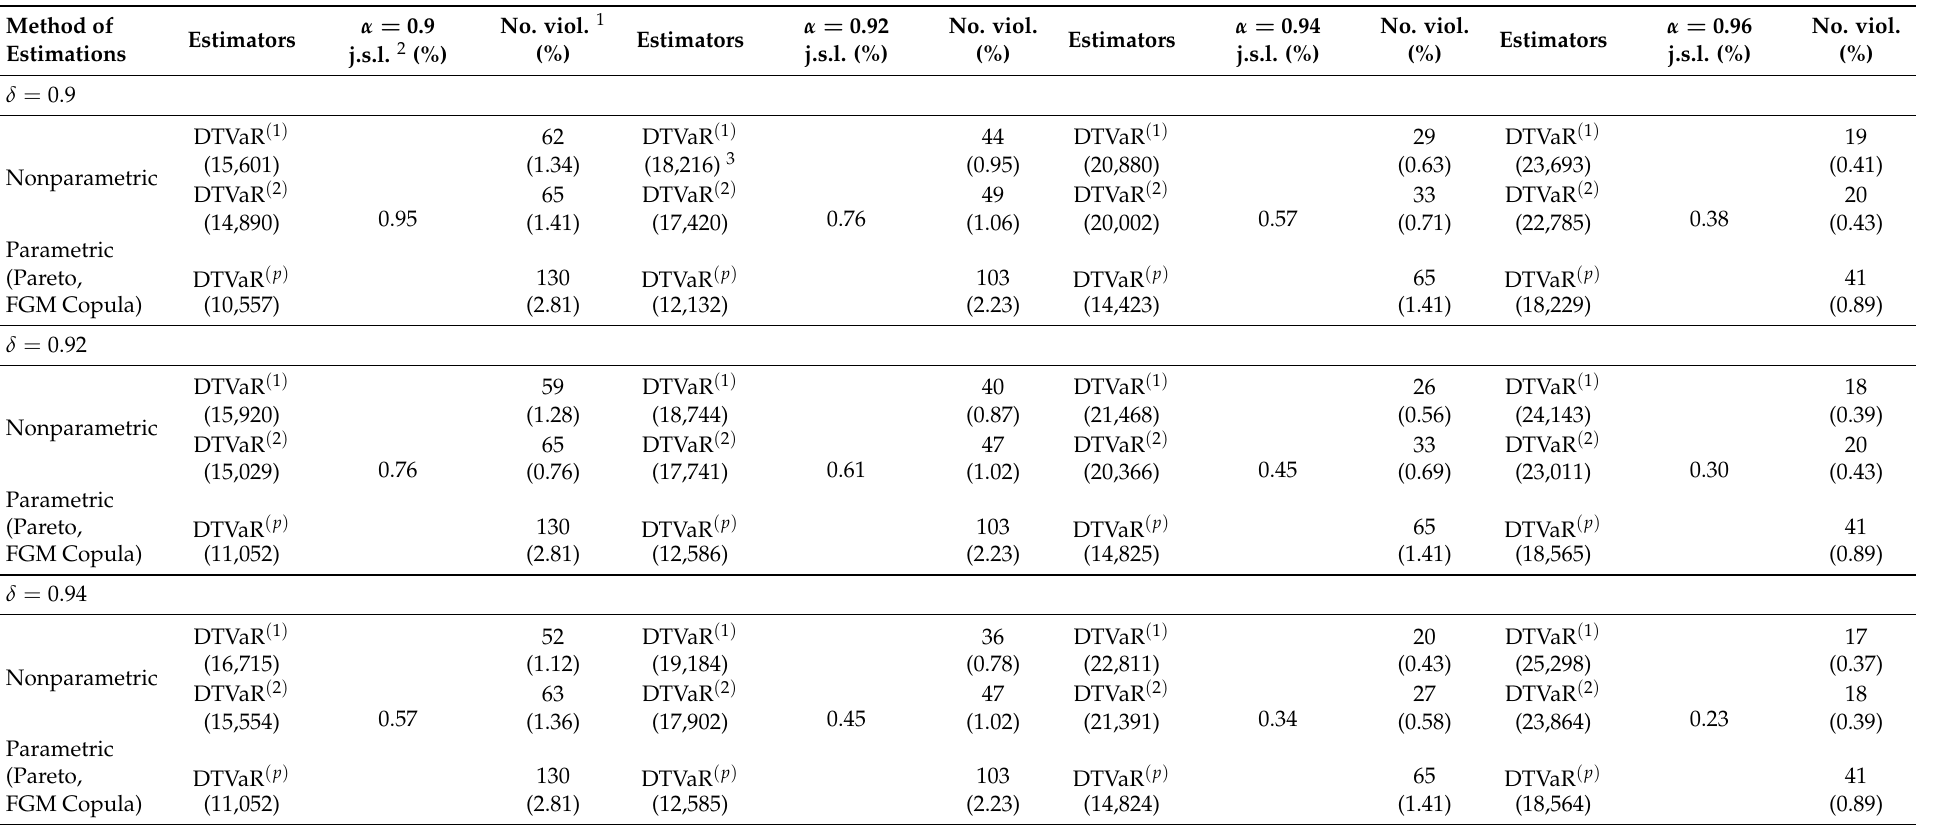
Table 2. Joint significance level and number of violations of nonparametric estimates of DTVaR ˆ θ = − FGM